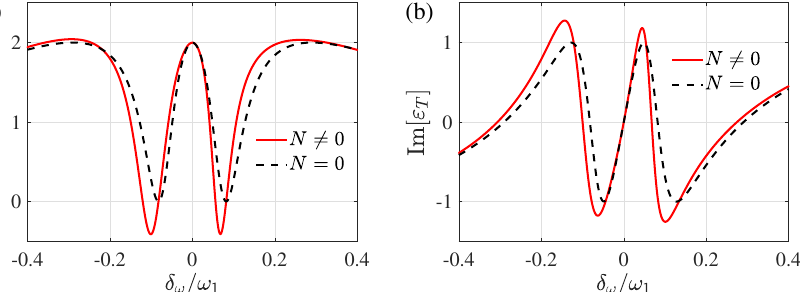
Figure 2. ( a ) The absorption property Re[ ε T ] and ( b ) dispersion property Im[ ε T ] of the probe output field as functions of the normalized frequency δ ω / ω 1 of the probe field. η = 1, κ = 4 κ 0 (with units of κ 0 = 2 π × 215 × 10 3 Hz), λ 0 = 8 × 10 35 Hz/m 2 , m 1 = m 2 = 145 ng, ω 1 = ω 2 = 2 π × 947 × 10 3 Hz, λ d = 1064 nm, L = 25 mm, Q 1 = ω 1 / γ 1 = 6700, Q 2 = ω 2 / γ 2 = 6700, and P = 10 mW